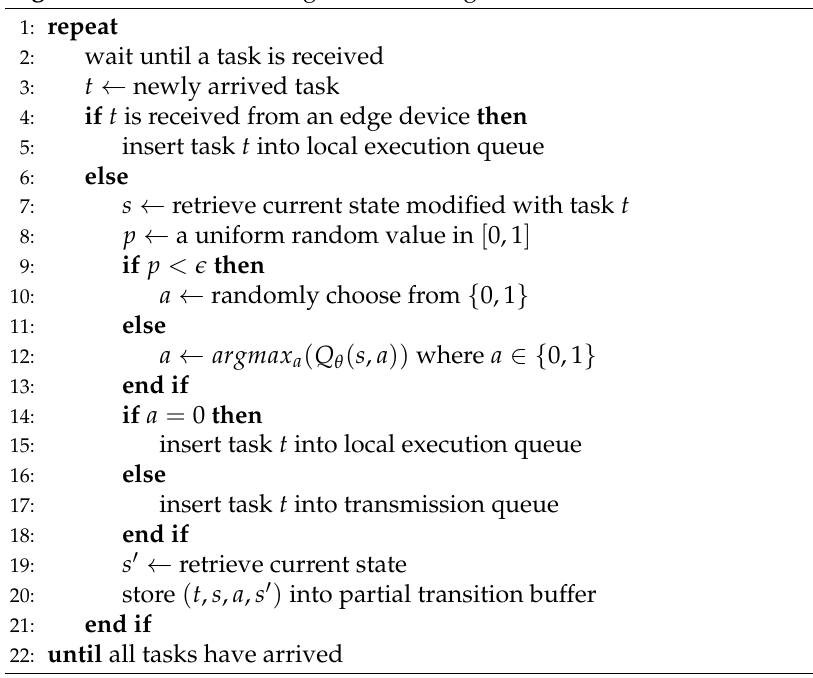
Algorithm 5 Task arrival algorithm for edge devices